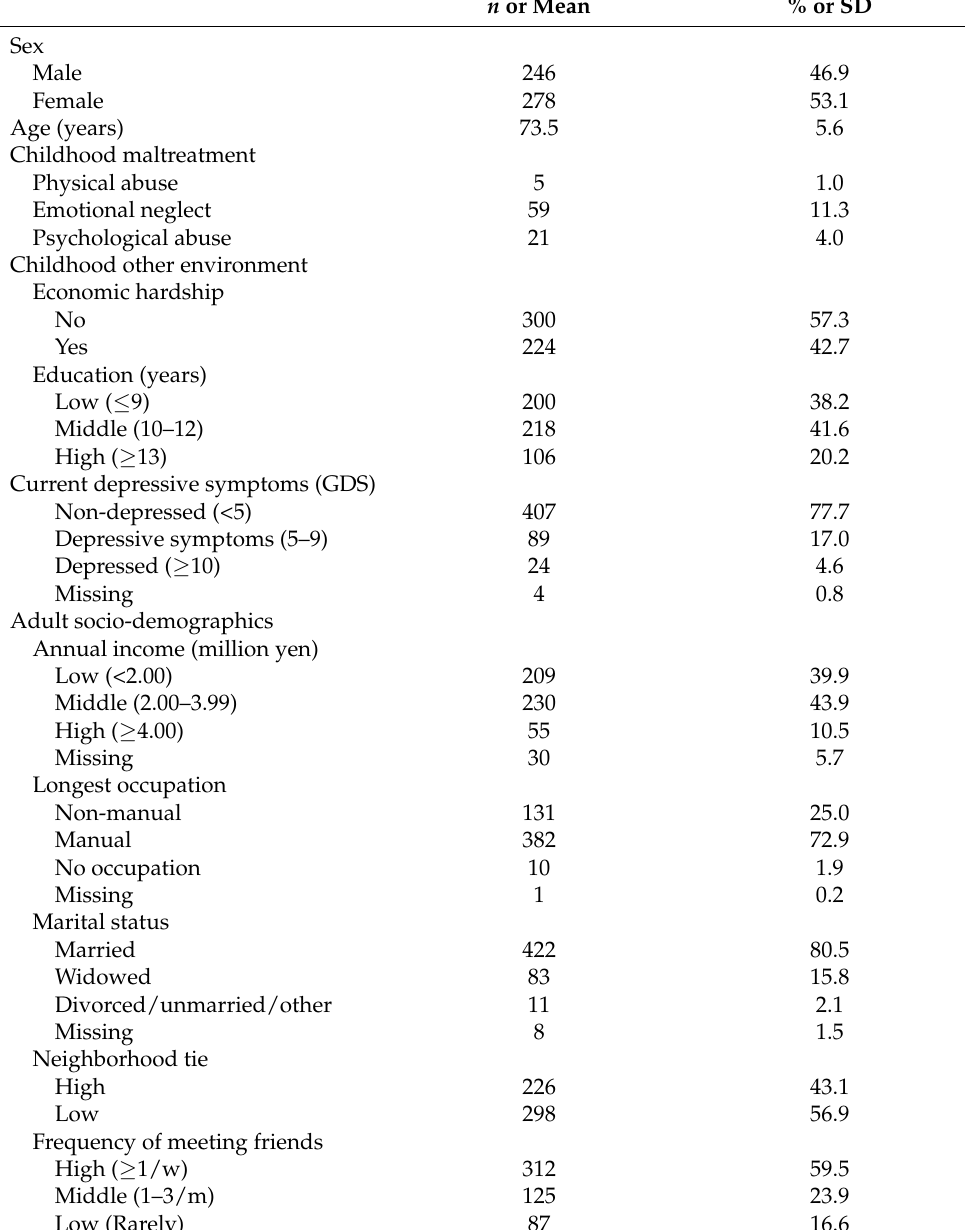
Table 1. Characteristics of participants ( n =